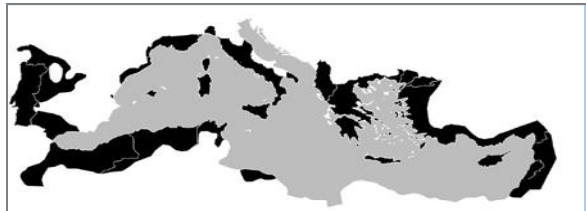
Figure 1. Mediterranean basin Area (Calcerano and Cecchini,